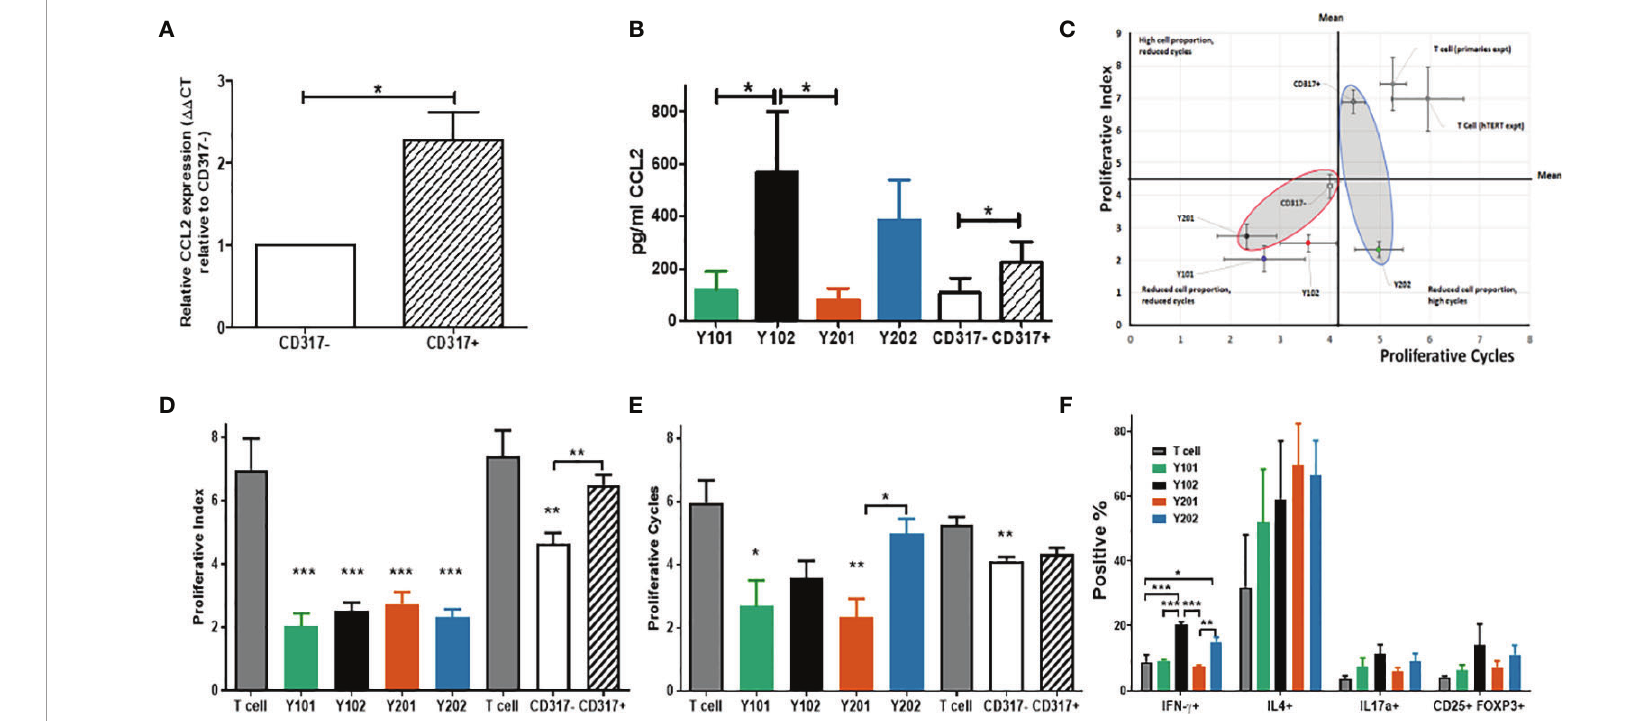
FIGURE 3 | In fl uence of CD317 neg MSCs and of CD317 pos MSCs on immune cell function (A) Comparative mRNA expression of CCL2 in primary MSCs sorted by CD317 expression (RNA was extracted from 7 different donors; experiments performed in triplicate, mean shown ± SEM). (B) CCL2 secretion in primary MSCs sorted by CD317 expression and MSC lines (from 4 different donors/4 different cell line passages; experiments performed in triplicate, mean shown ± SEM). (C) In vitro co-culture of hTERT immortalized lines Y201 and Y202 and primary CD317 neg and CD317 pos cells with activated T cells. CD317 neg cells reduce proportion of proliferating T cells and number of cell cycles achieved (D) hTERT cell lines signi fi cantly reduce proportion of proliferating cells as demonstrated through proliferative index (E) CD317 neg cell lines reduce proliferative cycles achieved by activated T cells in comparison to CD317 pos or T cell alone controls. (F) assessment of the in fl uence of MSC on T cell polarization in co-culture demonstrates CD317 pos cells in fl uence activated T cells to preferentially polarize towards IFN- g expressing (Th1) subset with indications of increased IL17a+ and CD25+FOXP3+ expressing cells. *p < 0.05, **p < 0.01, ***p <